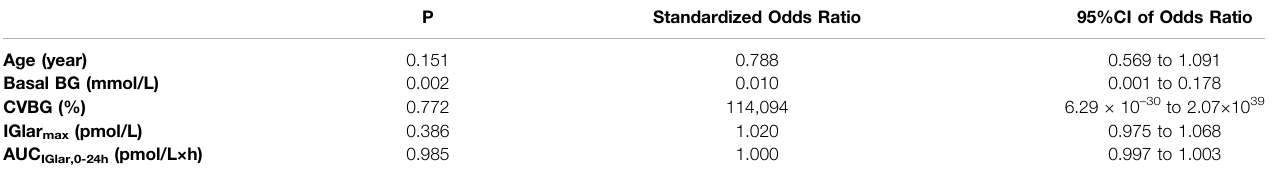
TABLE 4 | Odds ratios of factors for suf fi cient endogenous insulin suppression determined by logistic regression analysis. P Standardized Odds